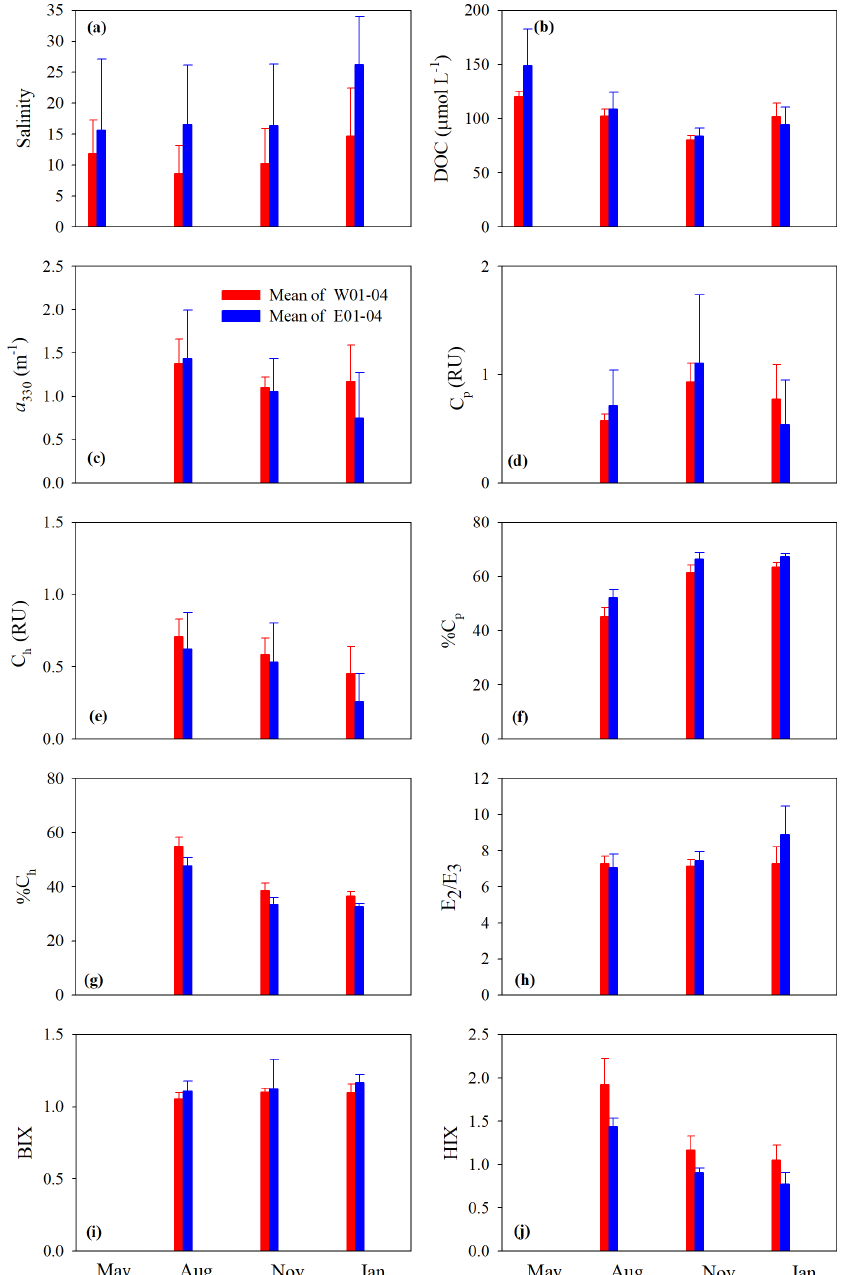
Figure 4. Mean values of salinity (a) , DOC (b) , a 330 (c) , C p (d) , C h (e) , % C p (f) , % C h (g) , E 2 / E 3 (h) , BIX (i) , and HIX (j) on the west and east transects. Surf and btm stand for surface and bottom respectively, and surf + btm denote surface combined with bottom. Error bars are 1 standard